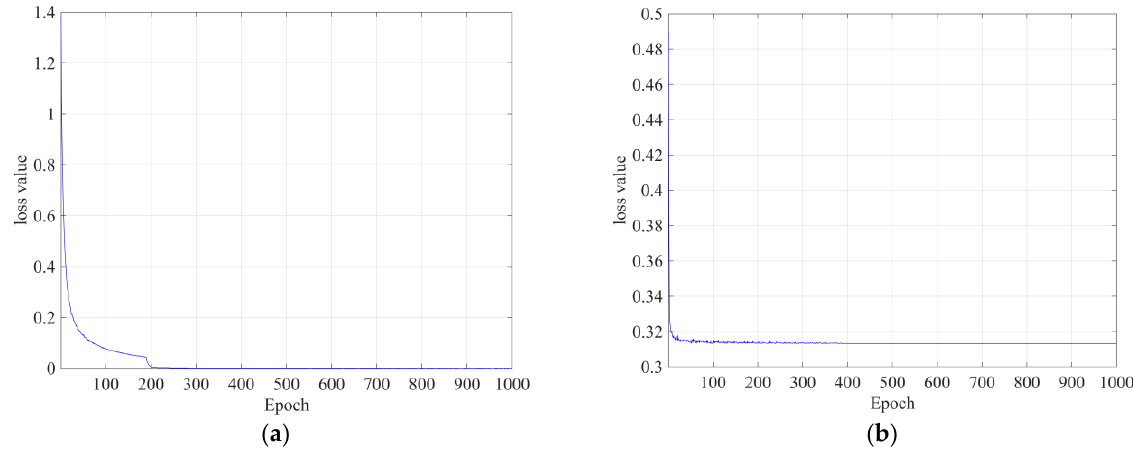
Figure 6. Training loss in each epoch: ( a ) detection models; ( b ) classification models.